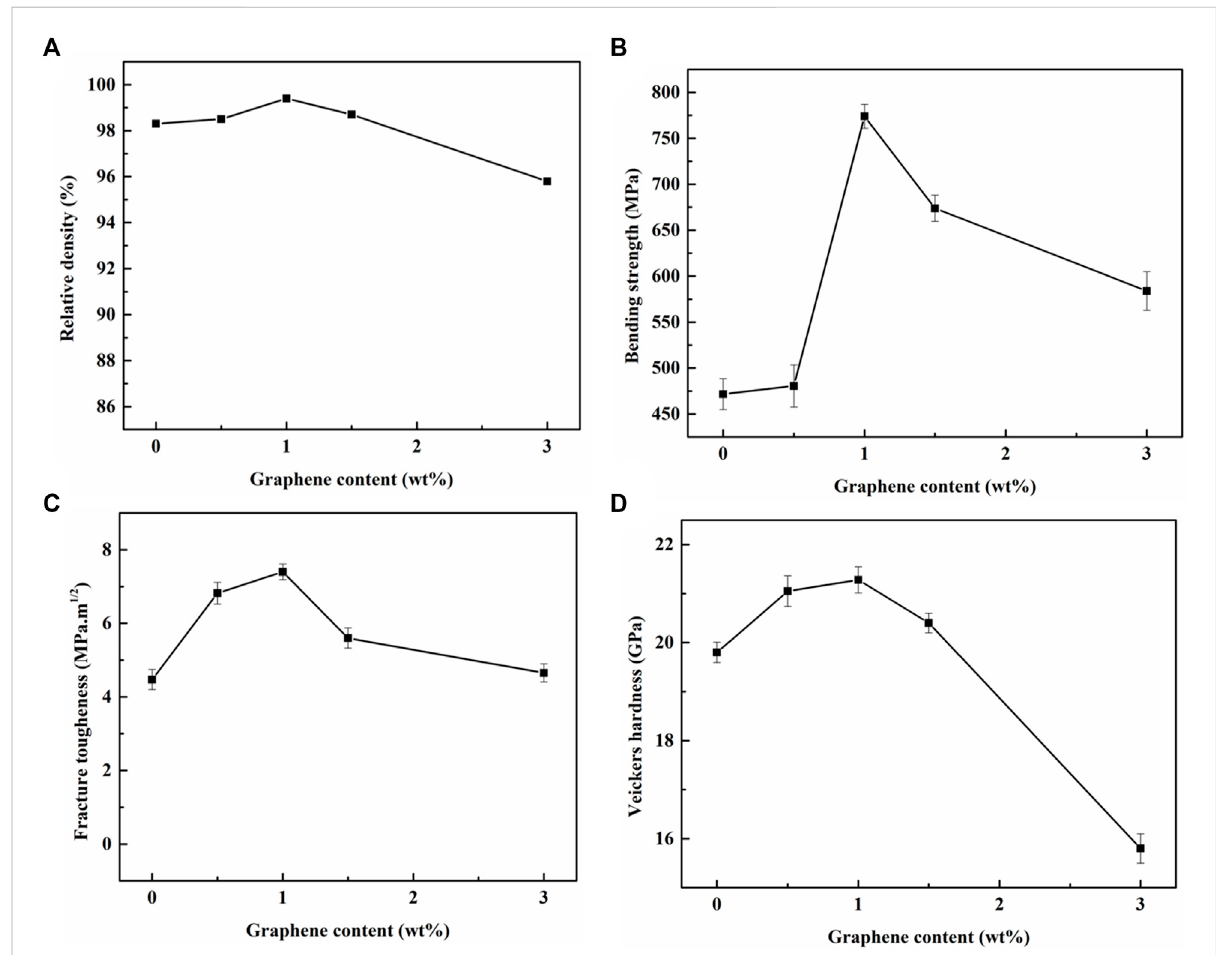
FIGURE 3 Variation curves of (A) relative density, (B) bending strength, (C) fracture toughness and (D) Vickers hardness of Al 2 O 3 -G composites with graphene